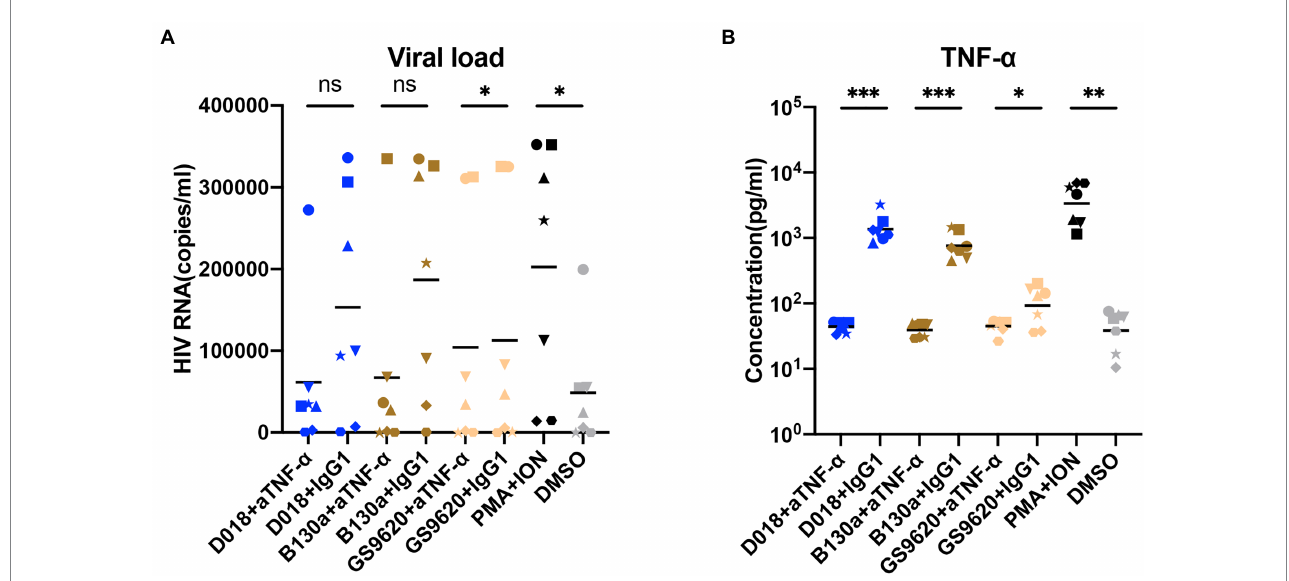
FIGURE 5 TLR7/8 agonists indirectly activate latent-infected cells derived from HIV-1 positive patients through TNF- α . (A,B) The PBMCs derived from HIV-1 viremic patients were stimulated by D018 (TLR7/8), B-130a (TLR8), GS9620 (TLR8) with anti-TNF- α monoclonal antibody compared with that of irrelevant IgG1 antibody control. (A) The HIV-1 RNA copies and (B) TNF- α concentrations in the supernatant were measured after stimulation. Data are shown as mean ± SD ( n = 7). Statistical difference was analyzed by paired t -test. **** p < 0.0001, *** p < 0.001, ** p < 0.01, * p < 0.05, n.s. not